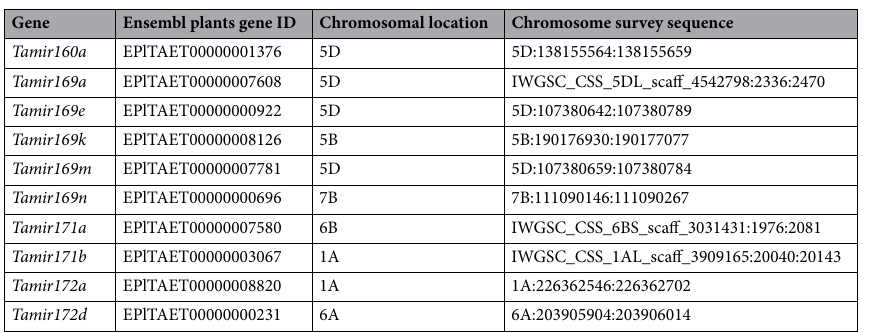
Table 1. Salt stress responsive MIR genes in Wheat.